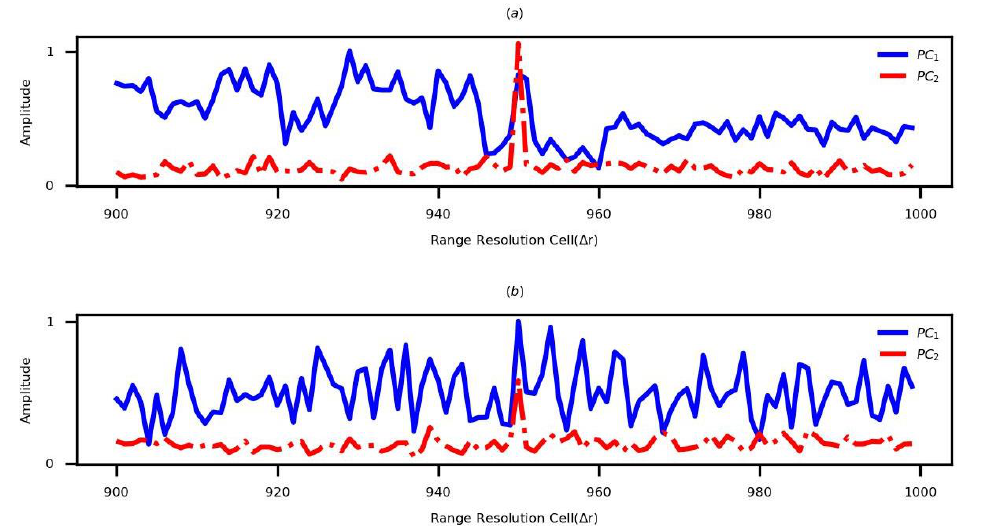
Figure 5. The HRRPs of the single-scattering-point target generated by the existing and the proposed PCTs based on different parameter sets. ( a ) Applying the parameter set 1. ( b ) Applying the parameter set